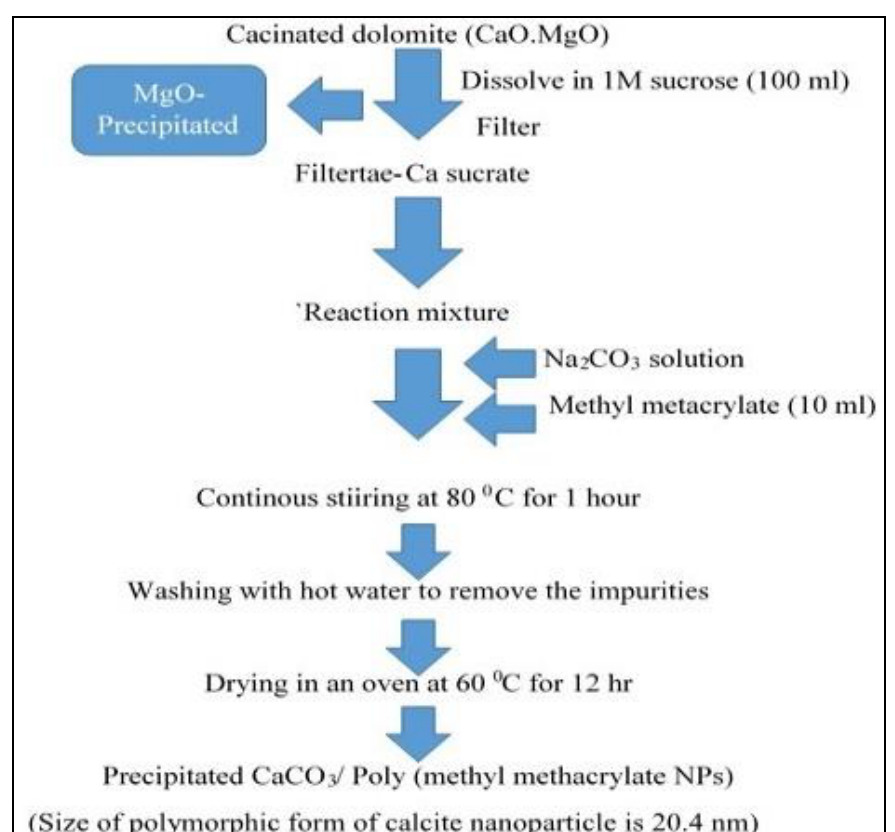
Figure 7. Steps involved in the synthesis of calcium carbonate nanoparticles from dolomite.